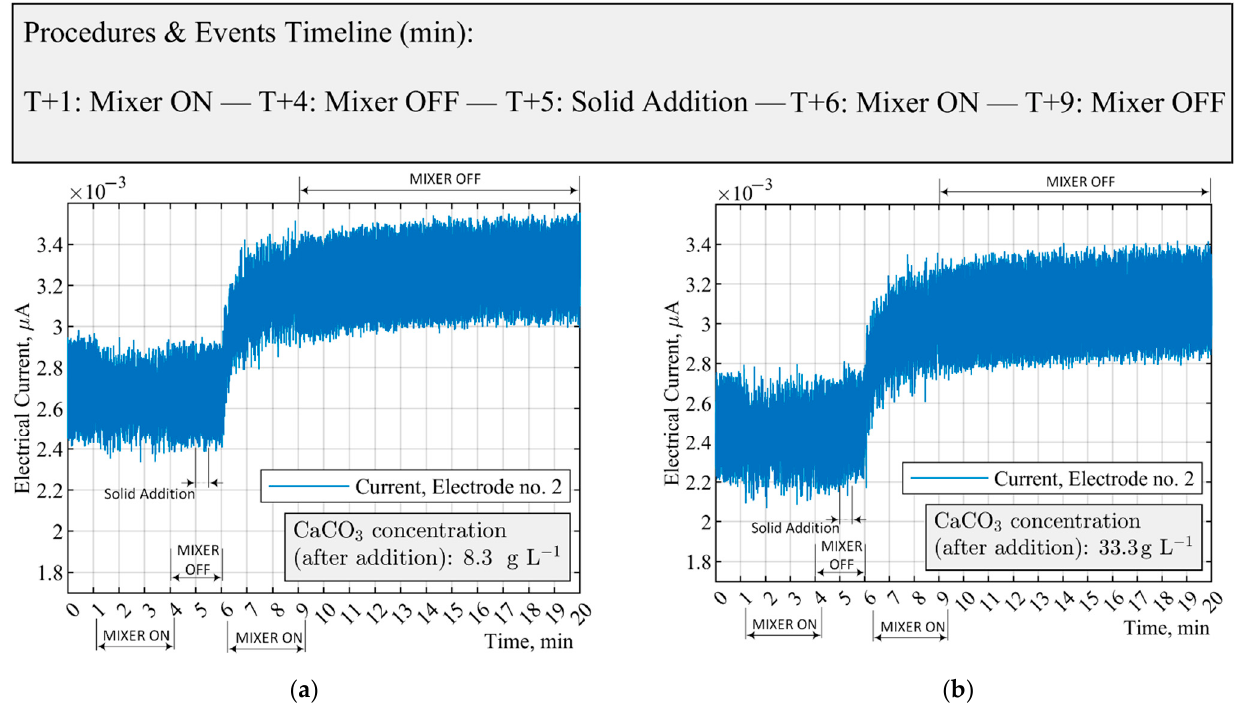
Figure 8. Variation in the electrical current of CaCO 3 suspensions based on single-electrode measurements; ( a ) CaCO 3 : 8.3 g L − 1 ; ( b ) CaCO 3 : 33.3 g L − 1 . The mixer switches on at 100 RPM. Table 3. The investigated scenarios for fault detection and diagnostics with electrode no. 2 of the ERT system. All the experiments are carried out at a mixing speed of 100 RPM and feed addition rate of 40 mL min − 1